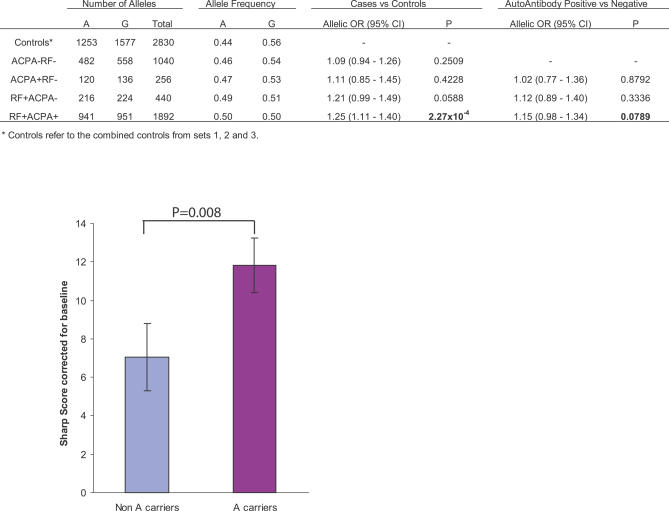
The A Allele of SNP14 Is Associated with Distinct Phenotypes of RA(Top, table) The frequency of the A allele of patients from whom baseline autoantibody status (ACPA and RF) were available was calculated. ORs and p-values were calculated between each subgroup and controls, and indicated a predominantly higher frequency of the A allele in ACPA- and RF-positive patients.(Bottom, bar graph) Progression of joint damage in Sharp–van der Heijde units (“Sharp score”) is higher in the presence of the minor A allele of SNP14. Radiological data of 193 A carriers and 85 non-A carriers were available, and differences between the groups were calculated based on disease severity after 2 y corrected for baseline.